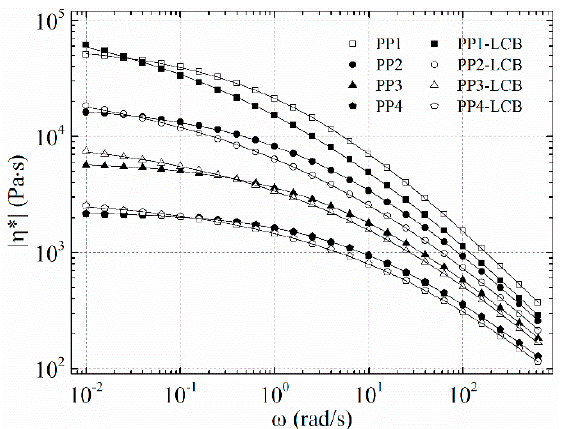
Figure 10. Dynamic viscosity as a function of angular frequency at 180 °C and the prediction of the Carreau–Yasuda model.